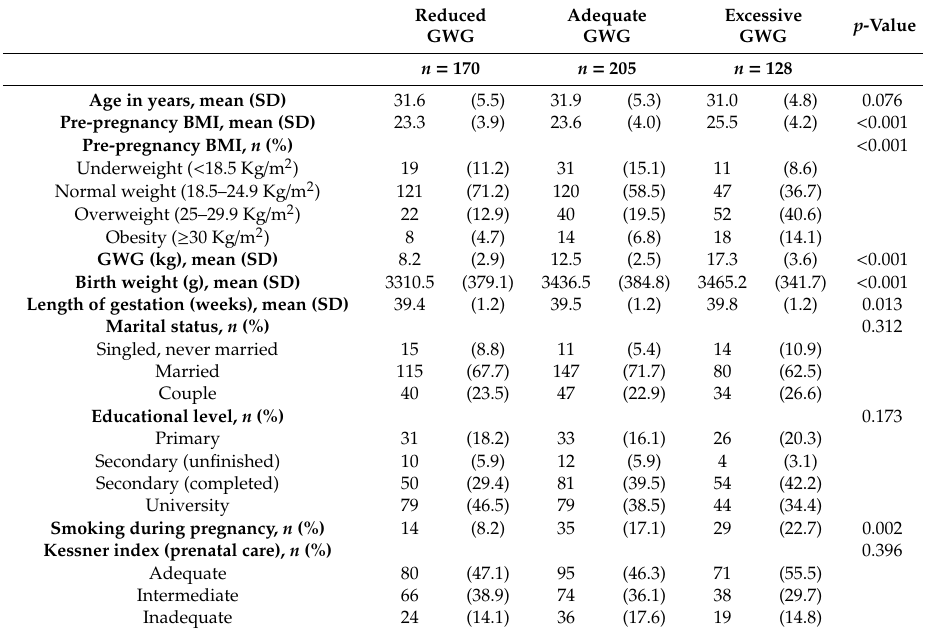
Table 3. Description of the study population characteristics in the study ( n =